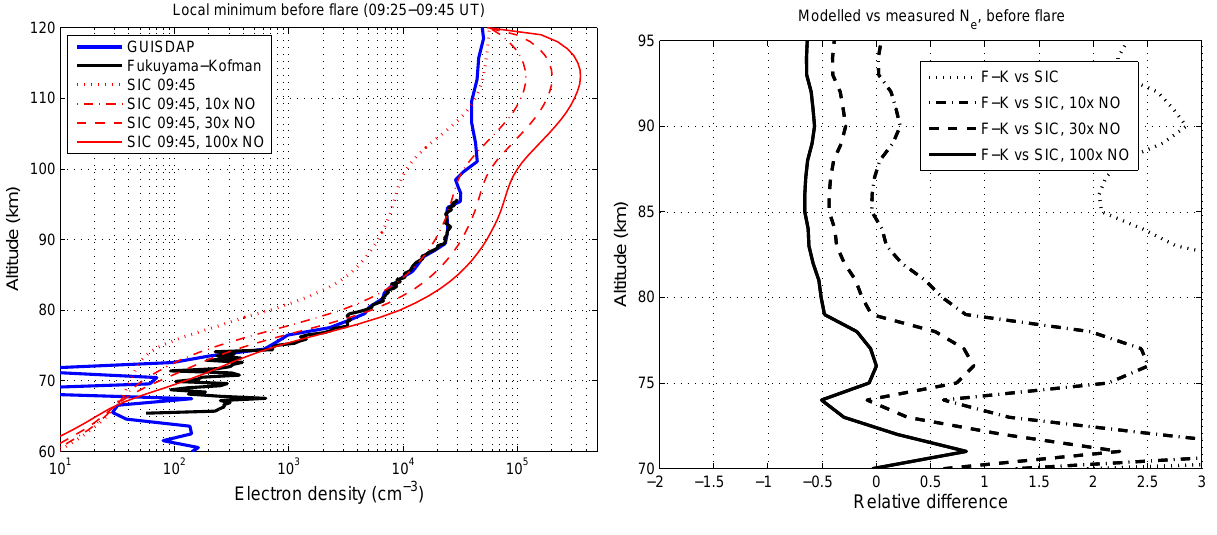
Fig. 4. The 28 October 2003 X17 flare event. Left plot: SIC and EISCAT results before the flare onset. GUISDAP profiles are averaged over the minimum in electron density preceding the flare, 09:25–09:45UT, bad profiles removed. The F-K MCMC fit was applied to data averaged over the same interval. SIC was run without hard-X-ray ionisation, the initial [NO] profile multiplied by 10, 30 and 100 at 08:00UT. The SIC results are shown for 09:45. Right plot (N.B: altitudes restricted to 70–95km): Relative differences between F-K MCMC and SIC electron densities, (N e ( F-K ) − N e ( SIC ))/N e ( F-K ) .